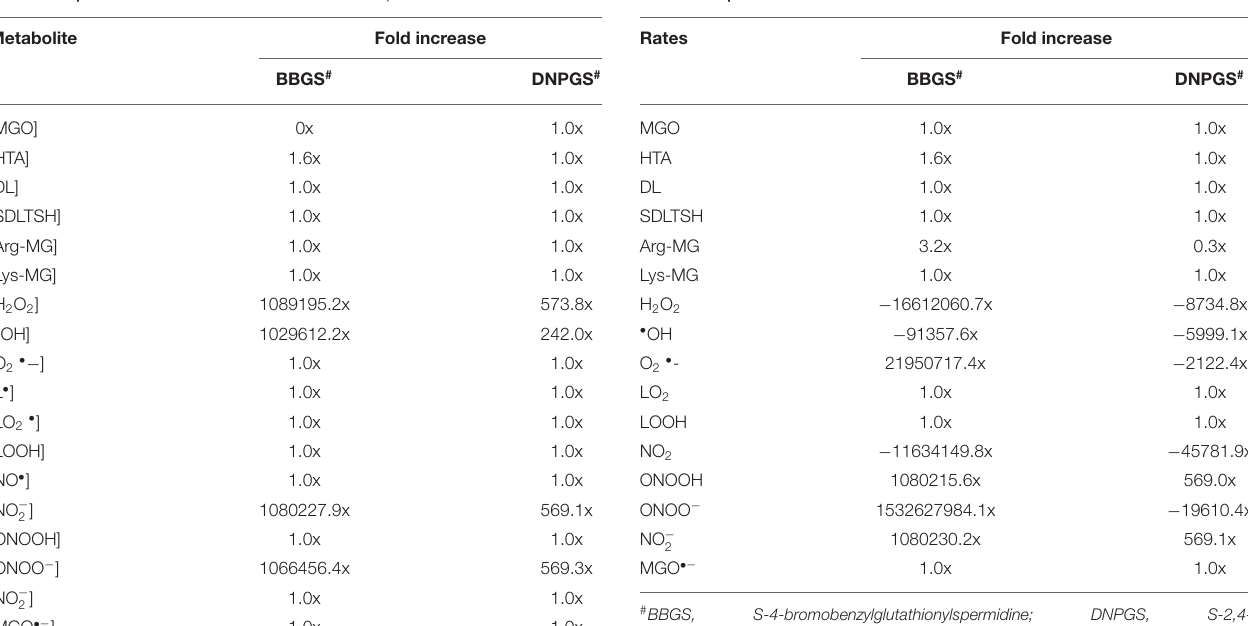
TABLE 4A | Effect of GLO I inhibition on metabolites produced. TABLE 4B | Effect of GLO I inhibition on metabolite